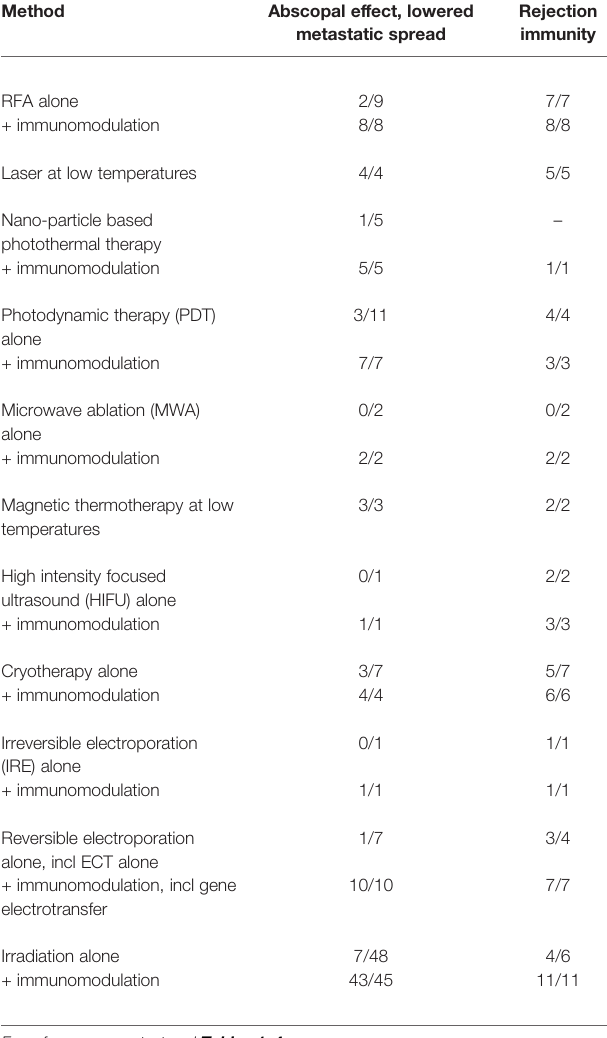
TABLE 5 | Portion of systemic effects after LTDs in preclinical